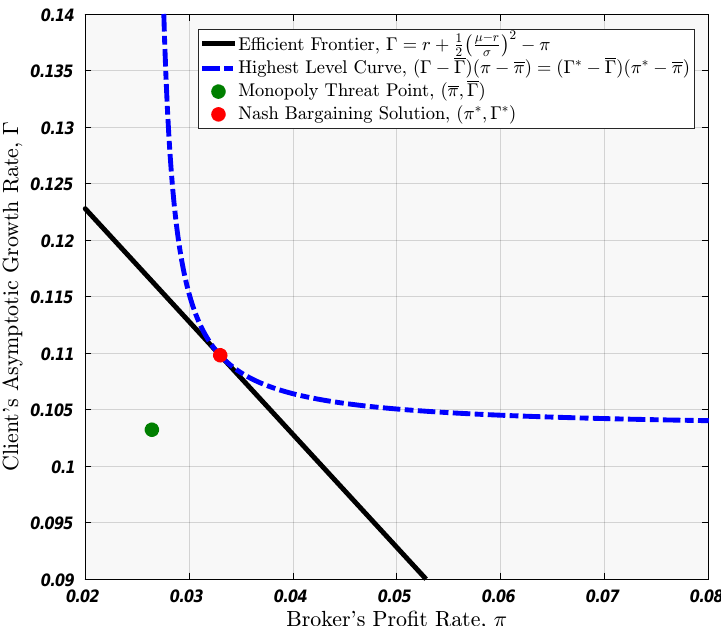
Figure 2. Gains from cooperation under Nash bargaining, ν : = 0.09, σ : = 0.15, µ : = ν + σ 2 /2, r : =